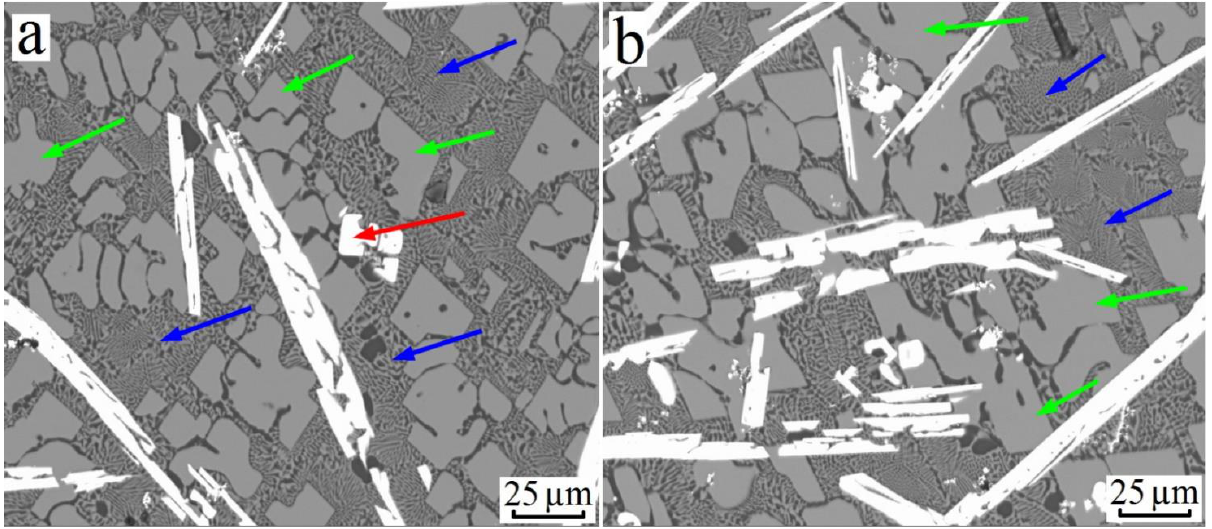
Figure 4. Distribution and forms of growth of stable and metastable aluminides in alloys: ( a ) Al – 29.73Cu – 13.24Hf (H1); ( b ) Al – 29.47Cu – 13.69Hf (H2) (magnification × 1000). The arrows point to main structural components of these alloys: the θ -phase Al 2 Cu (green arrows), the α -Al + θ eutectic (blue arrows) and L 1 2 trialuminides (red arrows).